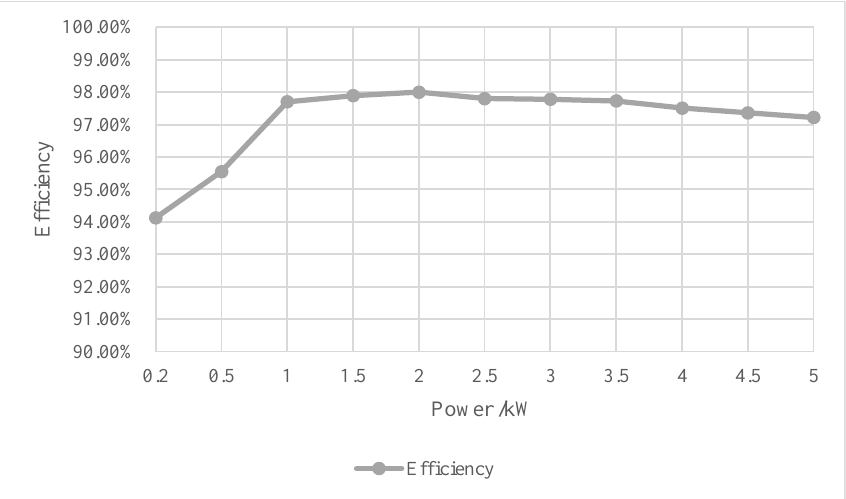
Figure 14. Efficiency of the PFC at different power levels.